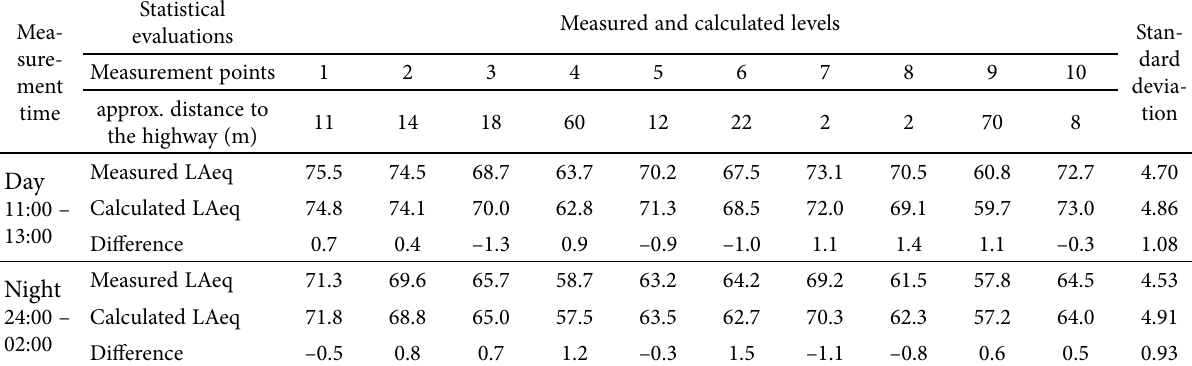
Table 4. Noise measurement data and calculation statistics